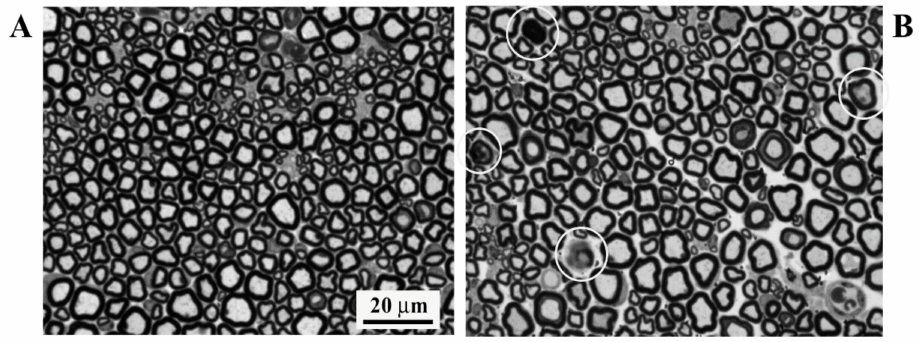
Figure 2. Morphological analysis of the sciatic nerve at 40 × magnification. ( A ) Exemplificative image of the control group animal specimen. ( B ) Representative image of an OHP group’s findings. White circles represent the few degenerating